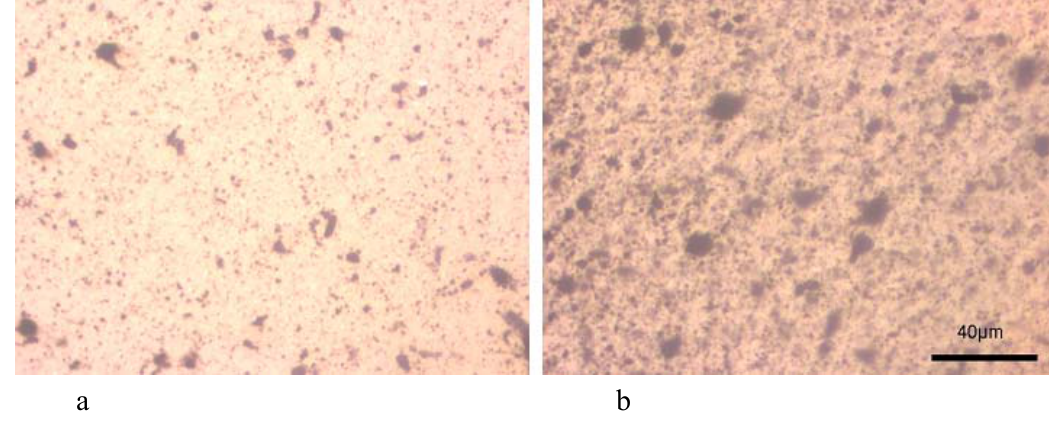
Figure 3. Optical micrographs of PP/MWCNTs nanocomposites containing